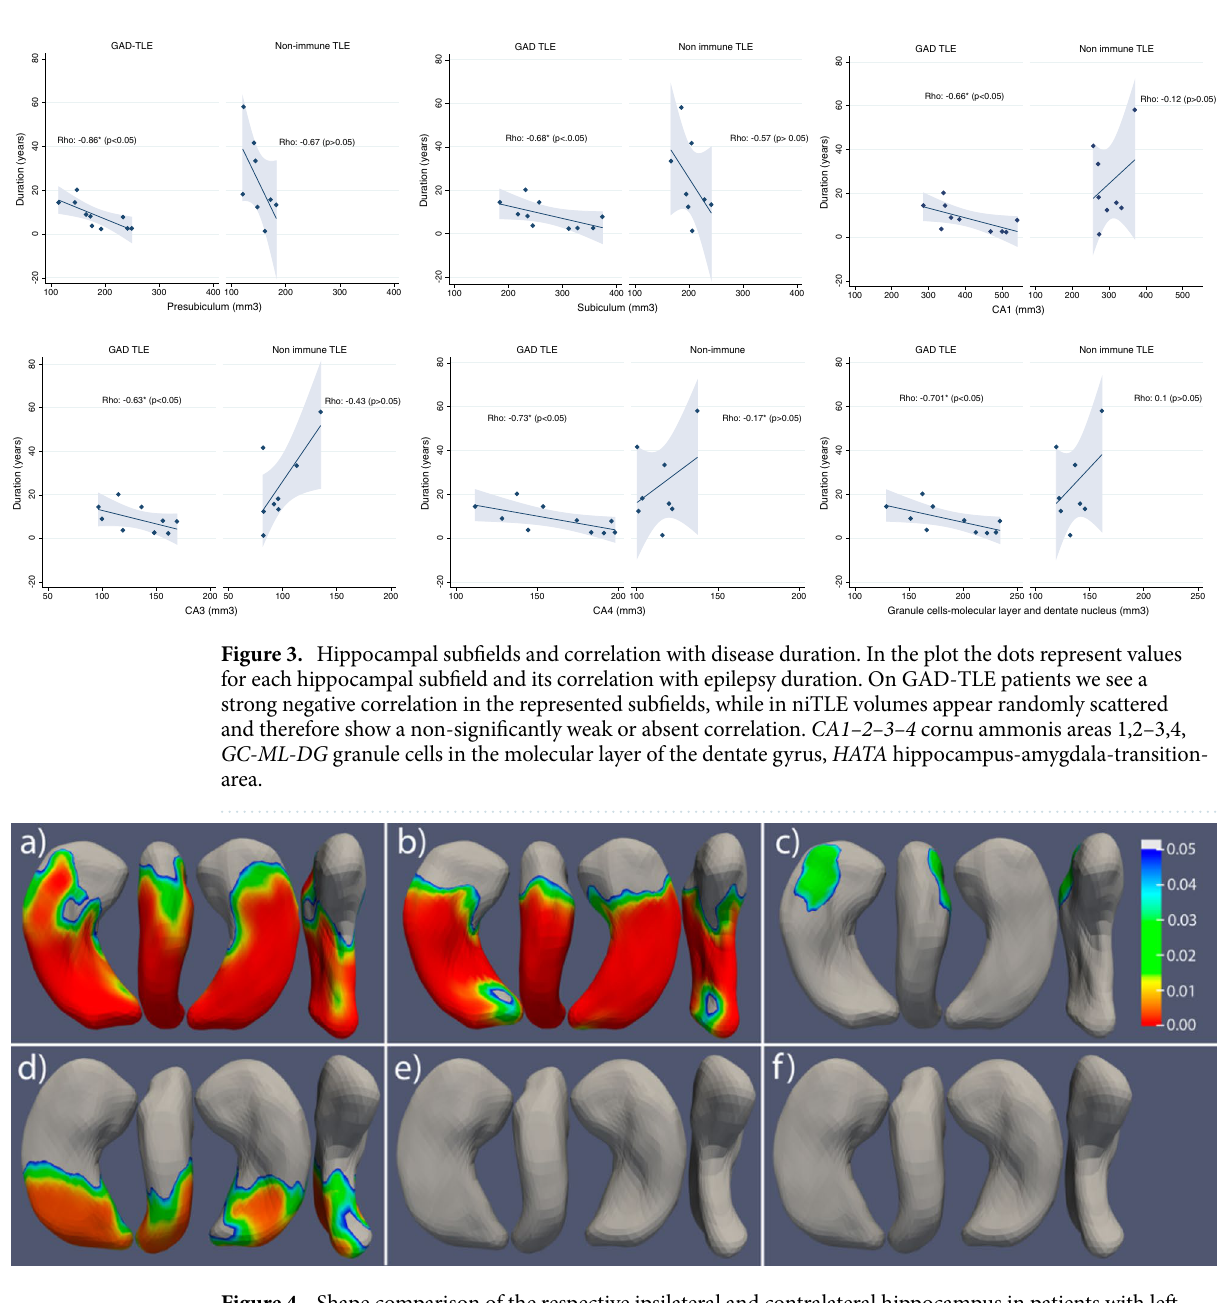
Figure 4. Shape comparison of the respective ipsilateral and contralateral hippocampus in patients with left GAD-TLE compared to left niTLE and HC. ( a ) Left hippocampus of niTLE versus HC; ( b ) left hippocampus of niTLE versus GAD-TLE; ( c ) left hippocampus of GAD-TLE versus HC; ( d ) right hippocampus of niTLE versus HC; ( e ) right hippocampus of niTLE versus GAD-TLE; ( f ) right hippocampus of GAD-TLE versus HC. Thresholded scale on the right indicates FDR corrected p values of significant shape change–cooler colors indicate lesser significance and warmer colors significant